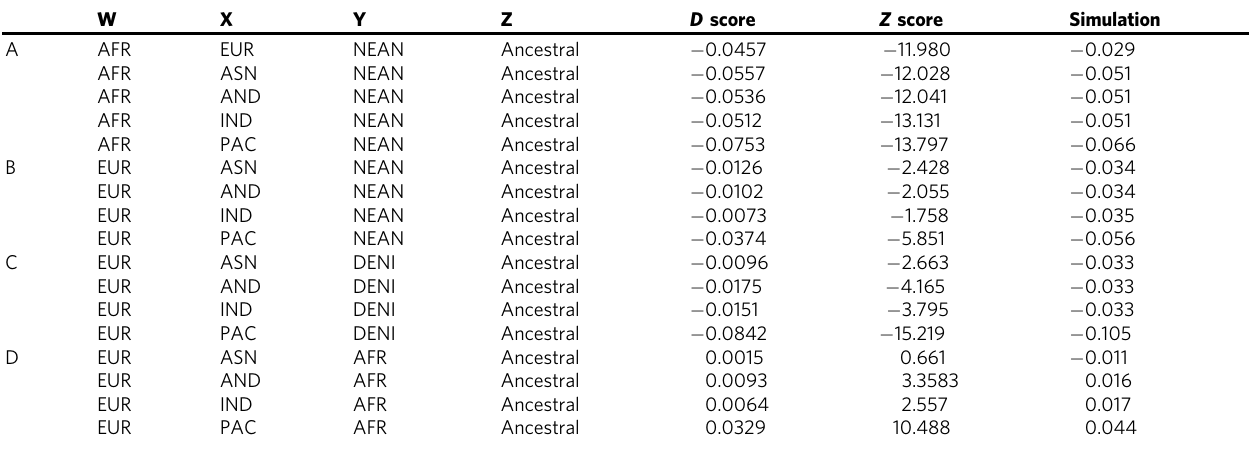
Table 1 D-statistics of Neanderthal and Denisova ancestry and dearth of African Ancestry in non-African populations